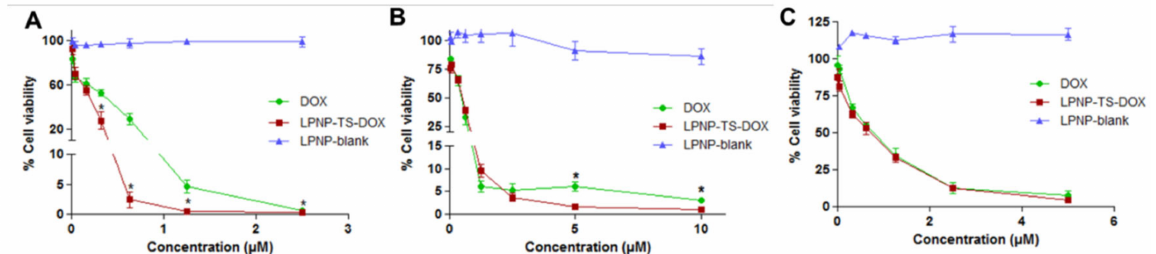
Figure 6. Cytotoxicity of NLP-blank, NLP-TS-DOX, and free DOX against ( A ) 4T1, ( B ) MCF-7, and ( C ) MDA-MB-231 cells, after incubation for 48 h. Data are expressed by the mean ± standard deviation of the mean (n = 3). Asterisks indicate statistically significant differences between the complexes at the same time point ( p < 0.05).